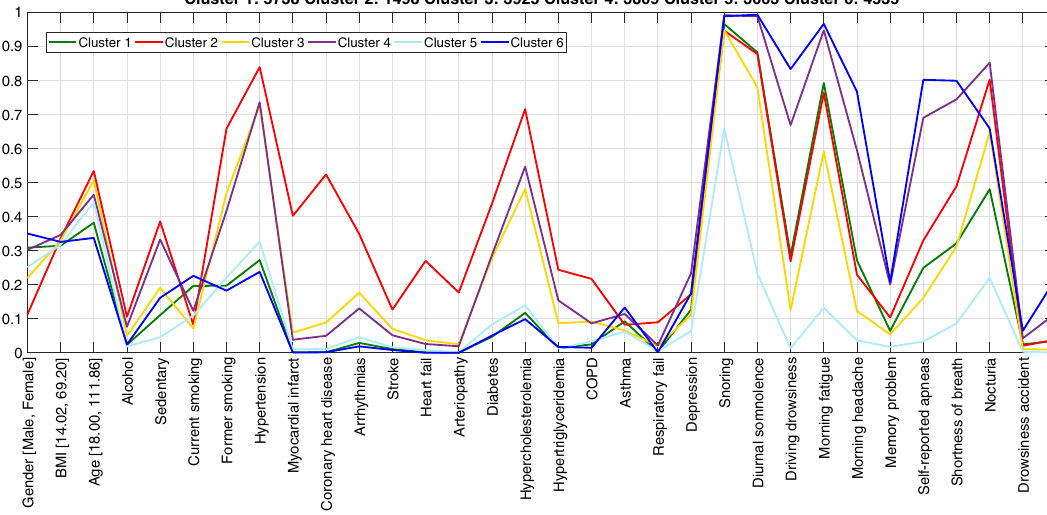
sion), except for Gender (percentage of Female), BMI and age (nor- malized into [0,1]) (best view in